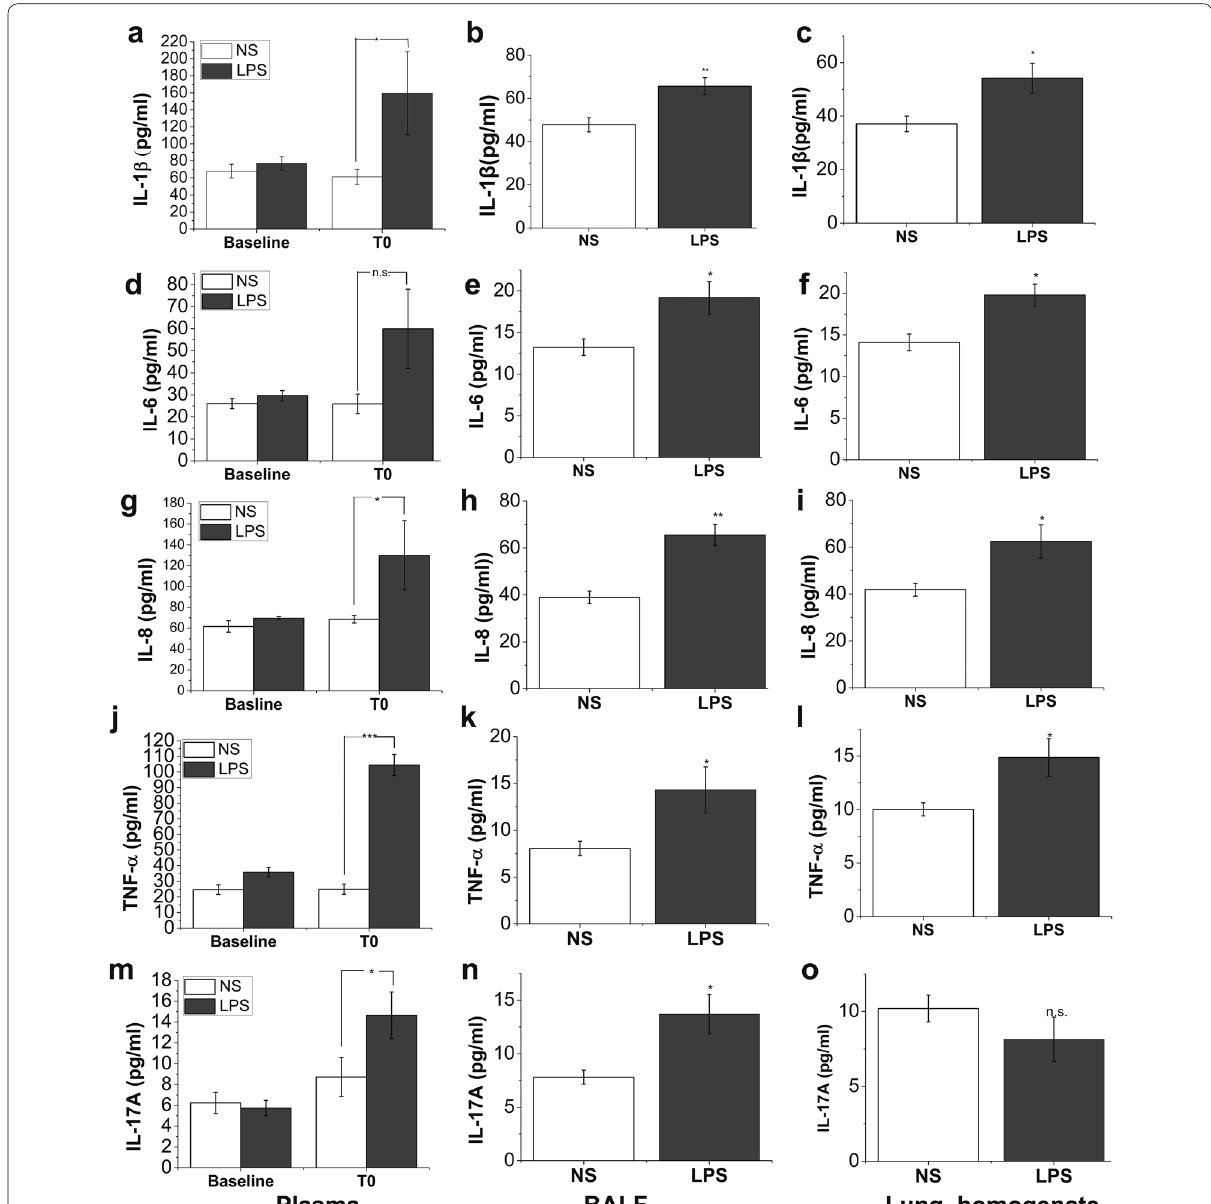
Fig. 2 Concentrations of circulating and pulmonary inflammatory parameters. In LPS group, plasma samples were collected before LPS challenge (baseline) and at the time when ARDS model had been well established (T0). BALF and lung homogenates were also prepared at necropsy. Samples from saline control group were also obtained at the corresponding time points. The level of circulating and pulmonary IL-1β ( a – c ), IL-6 ( d – f ), IL-8 ( g – i ), TNF-α ( j – l ) and IL-17A ( m – o ) was detected by using commercial ELISA kits. Data are presented as mean pared with saline (NS) group, * P < 0.05; ** P < 0.01; *** P <